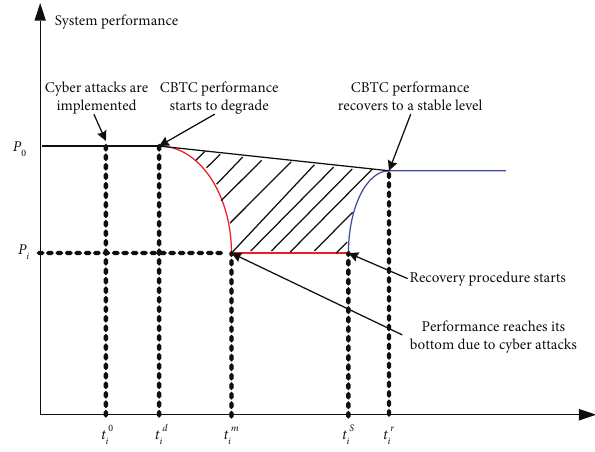
Figure 1: The resilience of a CBTC